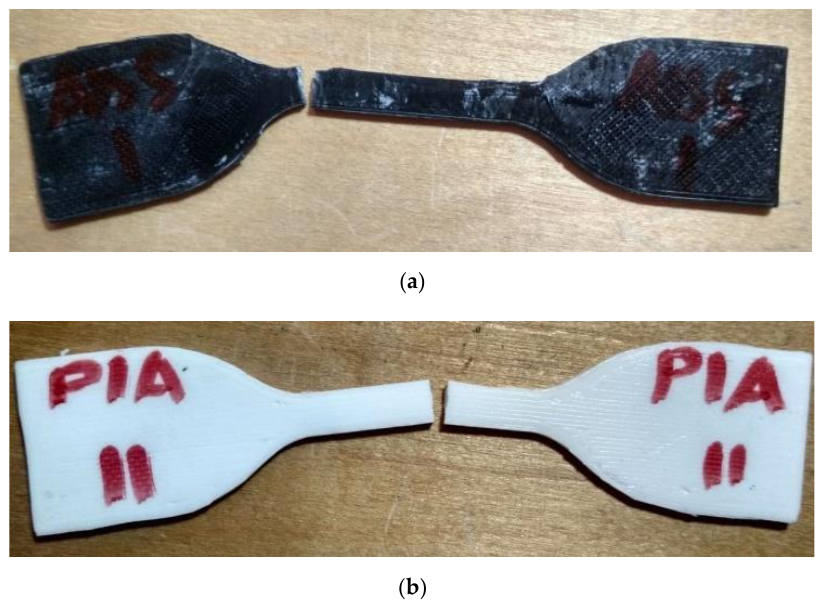
Figure 14. ( a ) Appearance of the fractured tensile specimen printed of acrylonitrile butadiene sty- rene (ABS); ( b ) appearance of the fractured tensile specimen printed of polylactic acid (PLA). Table 4. The mechanical properties of tensile specimens printed of ABS and PLA.